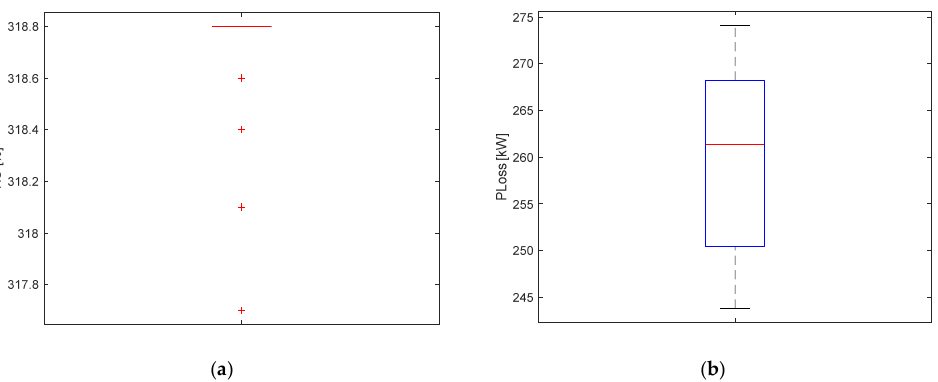
Figure 10. Dispersion of the MOAIS simulations, Case 2. HC on the left ( a ) and PLoss on the right ( b ).